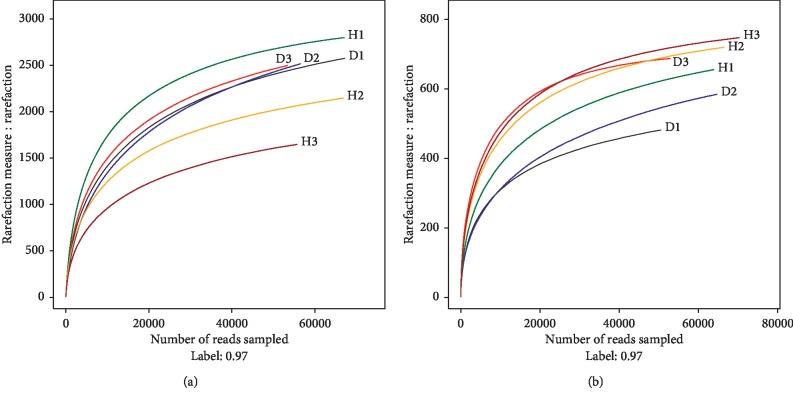
Bacterial (a) and fungal (b) rarefaction curves for all samples at a 97% OTU sequence similarity threshold.